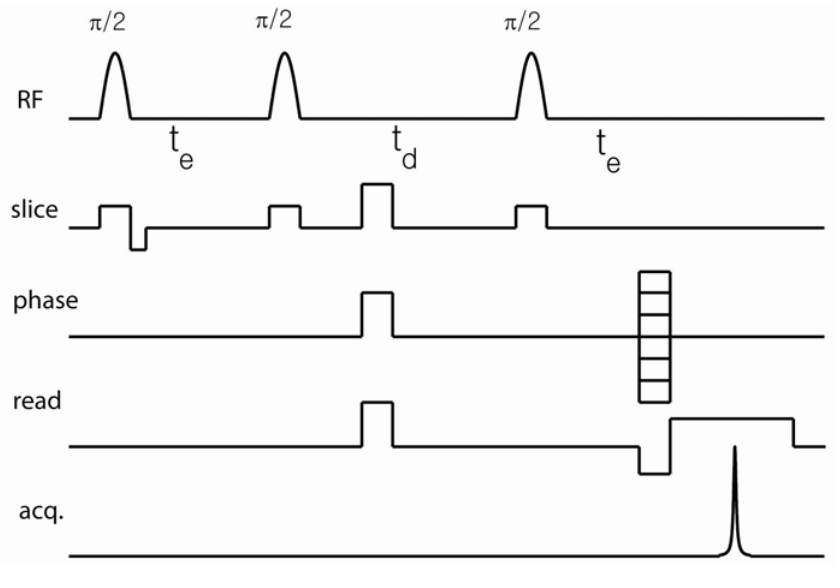
Figure 2. Slice-selective 2-dimensional (2D) spin-warp DDIF imaging sequence. The spoiler gradient was applied during (cid:1872) to remove the unwanted coherence pathway signal. (cid:3031) The readout gradient was applied just before stimulated echo acquisition to reduce signal decay due to the external field gradients at different diffusion times. A pulsed-field gradient can be applied during (cid:1872) to extract cross-terms between the internal and external (cid:3032) gradients. Reproduced from Reference [23] with